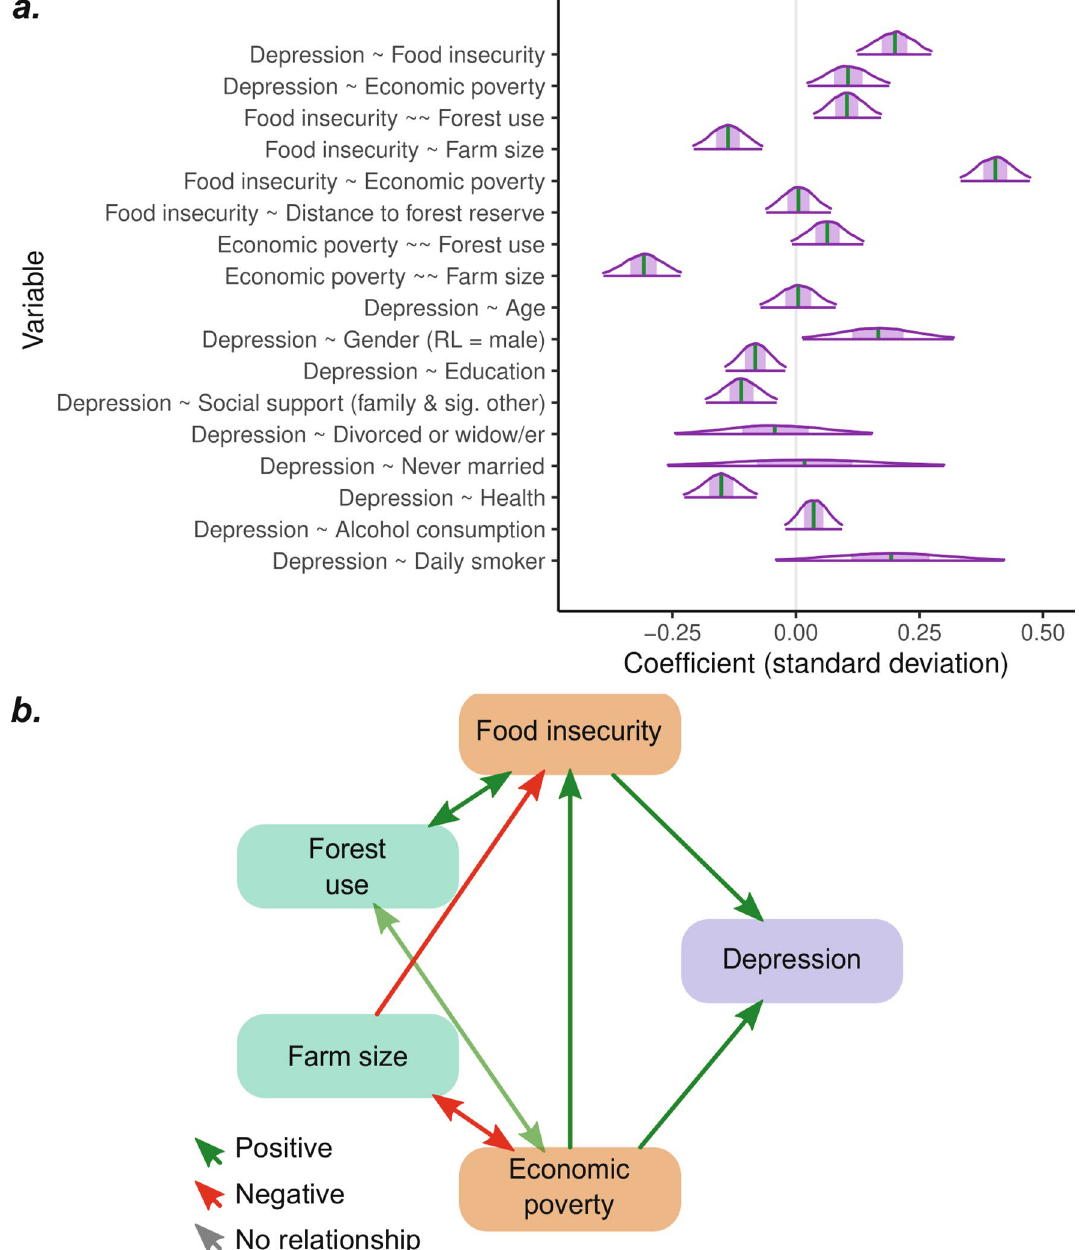
Figure 6. Bayesian structural equation modelling results. Panel ( a ) describes the coefficient estimates from the Bayesian structural equation model using data from 695 respondents. The vertical green line represents the point estimate (median of the posterior distribution), the dark purple line represents the 95% credibility interval, and the shaded area represents the 50% credibility interval. The estimated associations between depressive symptom severity and the community dummy variables are not shown. Coefficient estimates are presented in standard deviations. Panel ( b ) illustrates the direction of association between each variable (excluding covariates). The semi-opaque line indicates a marginally statistically uncertain association (as shown in Panel ( a ). Key: ‘ ~ ’ = regression, ’ ~ ~ ’ = co-variance, ‘RL’ = reference